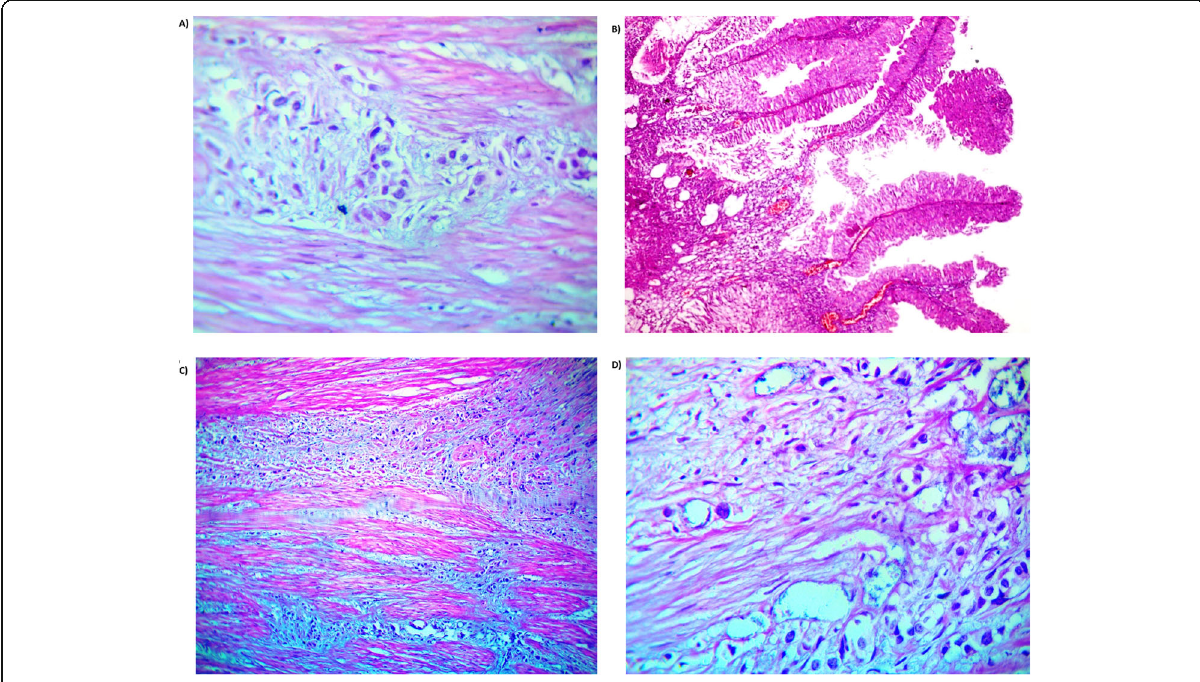
Fig. 1 Cross section of urothelial bladder tissues stained with H&E. a High-grade urothelial carcinoma infiltrating deep muscle layer (pT2) (H&E × 400), b papillary urothelial neoplasm of high malignant potential (H&E × 200) (pTa), c high-grade urothelial carcinoma infiltrating deep muscle layer (pT2) (H&E × 200), and d high-grade urothelial carcinoma infiltrating deep muscle layer (pT2) (H&E ×